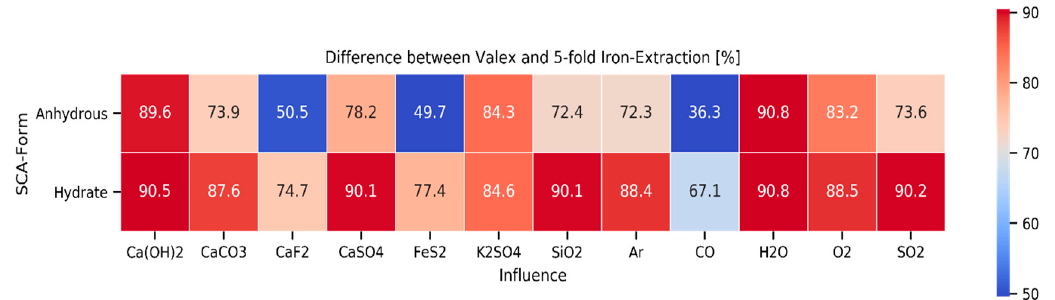
Figure 8. Difference between valex and 5-fold iron extraction for various atmospheres and secondary compounds in combination with anhydrous or hydrated SCAs, mean values for temperatures, pressure of 1 atm, and stoichiometry of 1 .